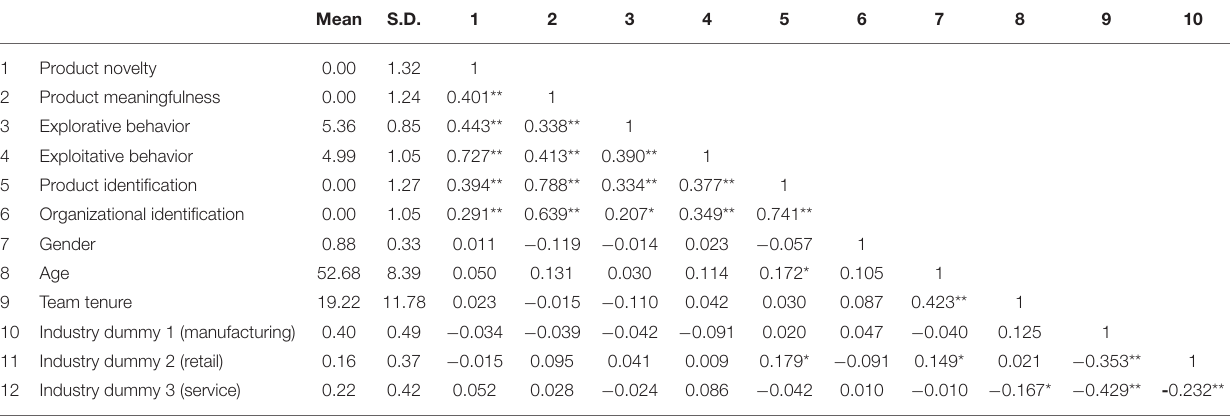
TABLE 1 | Descriptive and correlation statistics.